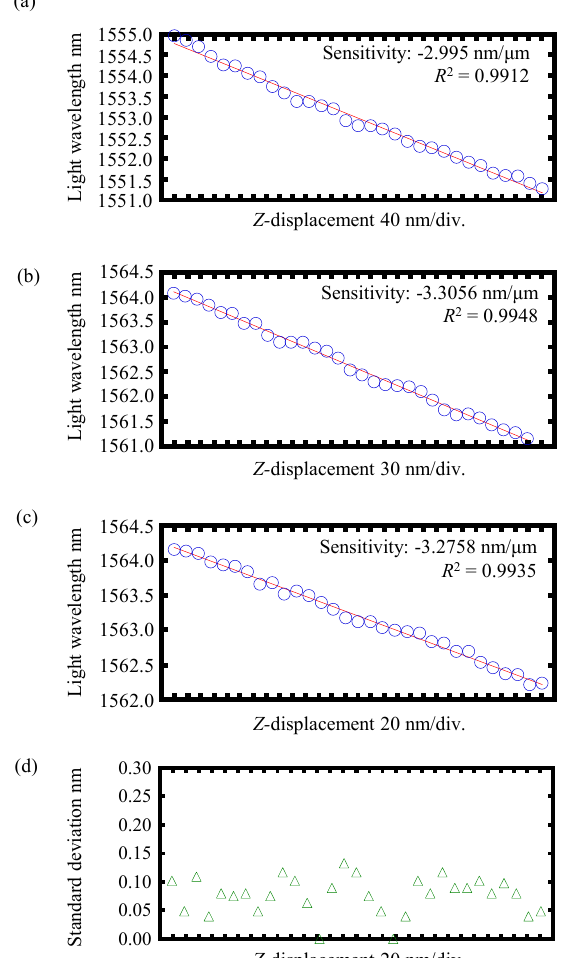
Figure 14. Evaluation of the measurement resolution of the mode-locked femtosecond laser differential chromatic confocal probe with the off-axis differential method. ( a ) Measured variation of the stage position moved in a step of 40 nm; ( b ) measured variation of the stage position moved in a step of 30 nm; ( c ) measured variation of the stage position moved in a step of 20 nm; ( d ) standard deviation of the repeated measurements in ( c ).